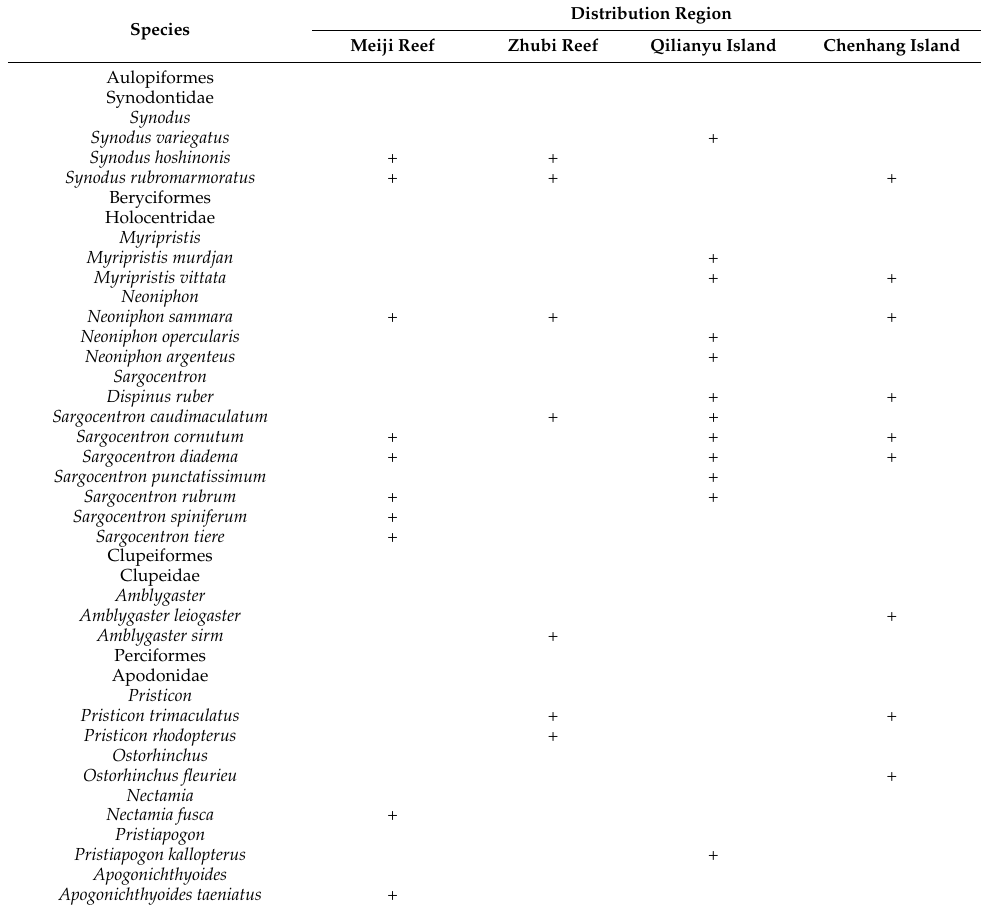
Table A1. Distribution of fish in the coral islands/reefs in the South China